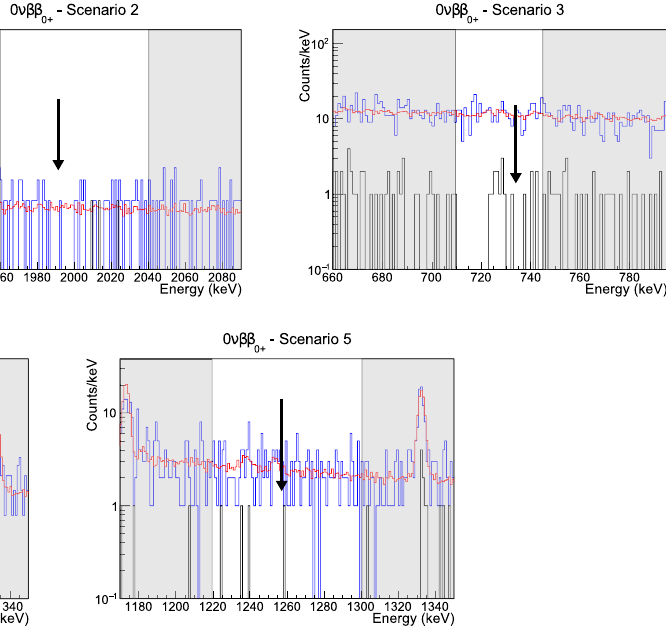
in black are data with energy cuts. The non-shaded area represents the fit range, while the black arrow points to the location of the expected ββ 0 + 1